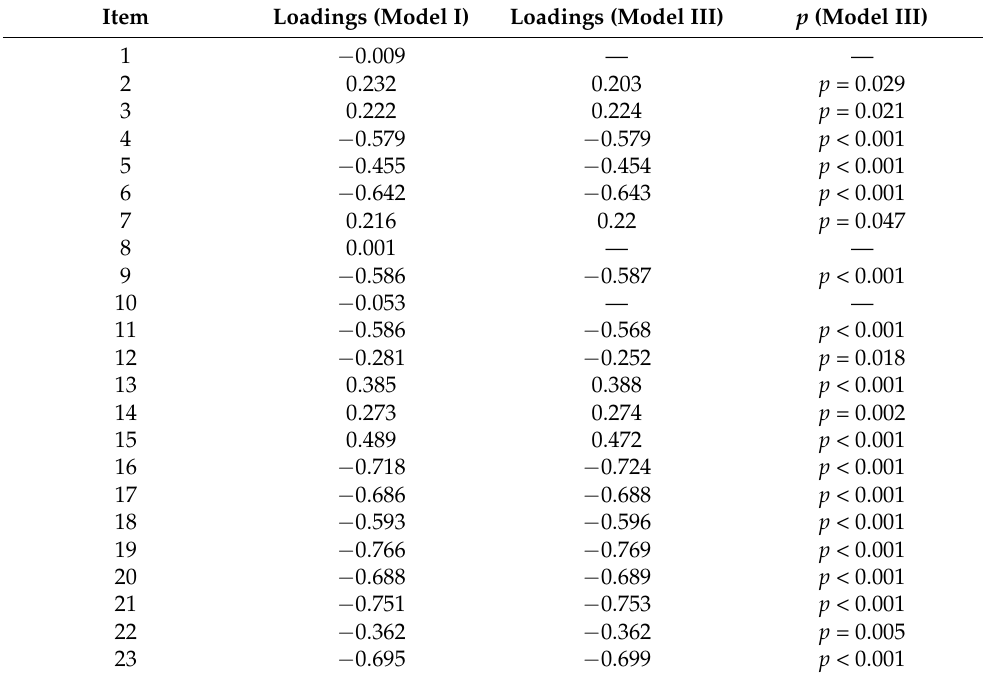
Table 5. Results of load values of individual